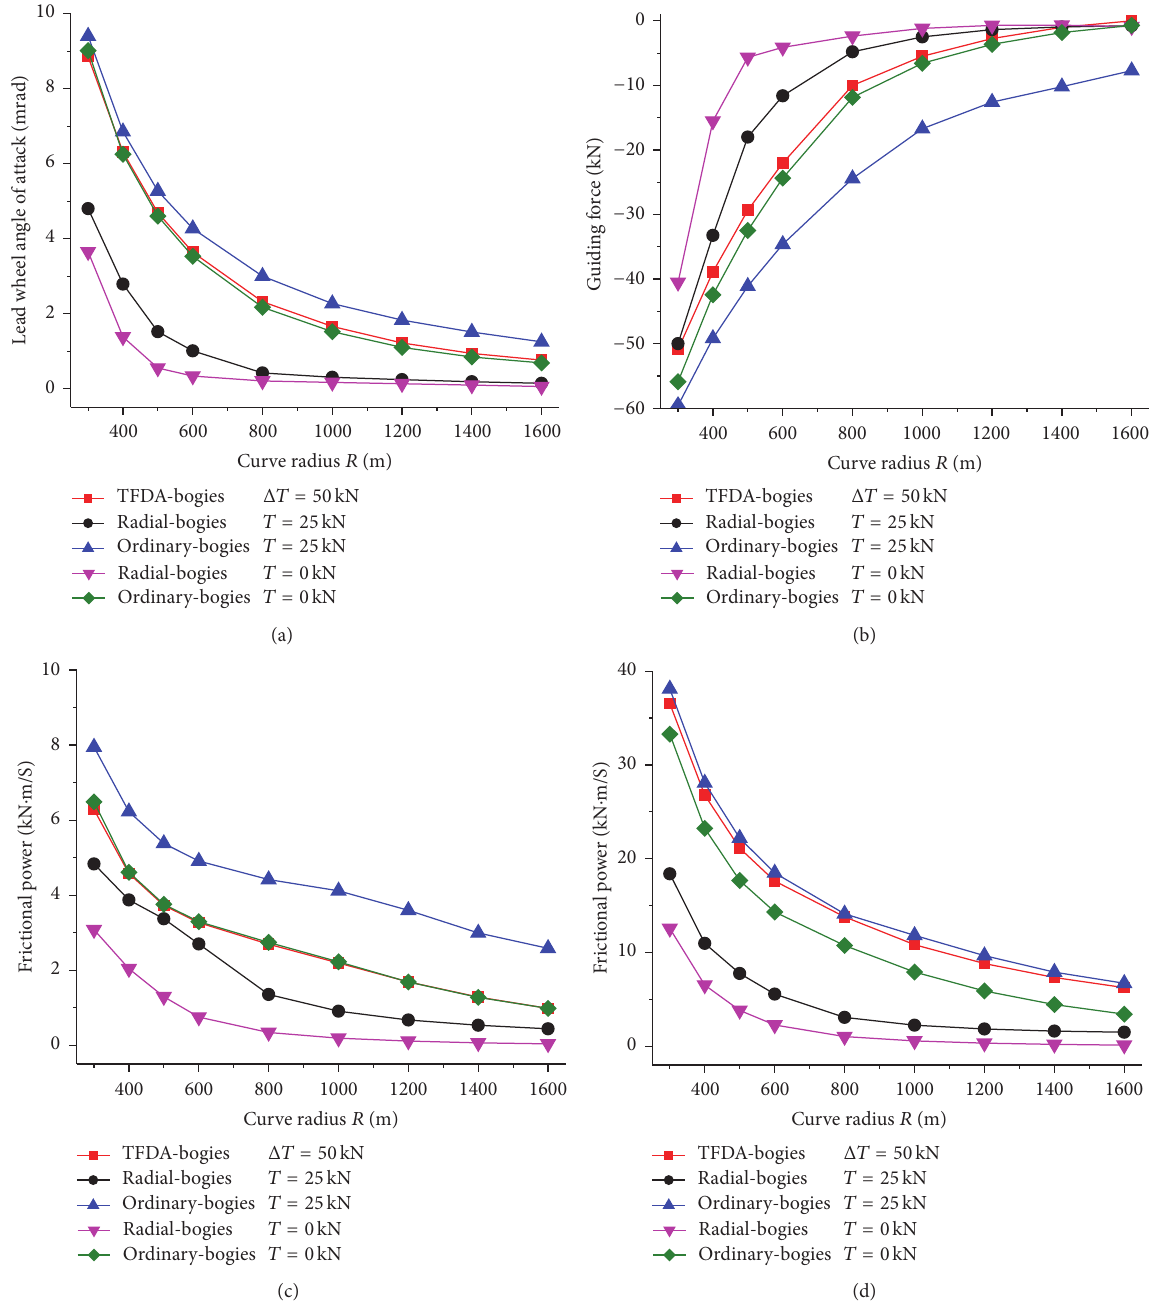
Figure 7: Each bogie performance comparison, (a) lead wheel angle of attack, (b) lead wheel lateral force, (c) lead wheel friction power, and (d) total vehicle friction